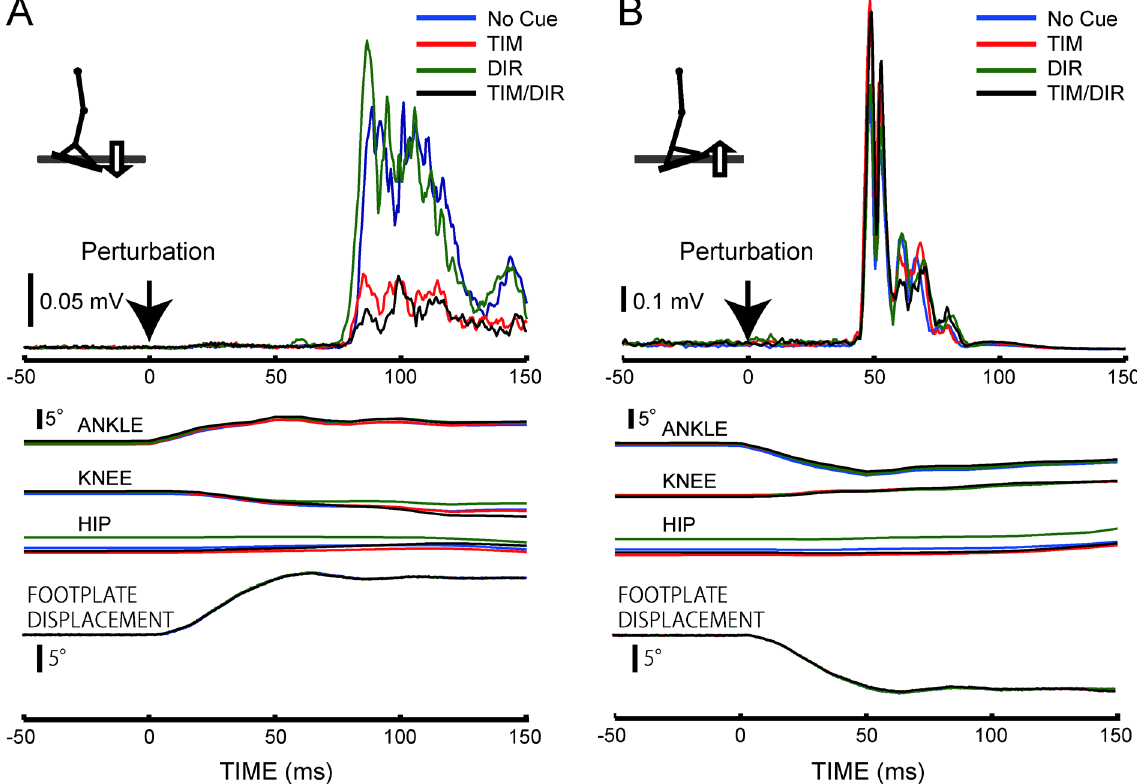
Fig 2. Representative ensemble-averaged waveforms of the stretch reflex responses with movement trajectories of the ankle, knee, and hip joints under the different cue conditions in a single subject. (A) In the TA muscles due to toes-down rotations. (B) In the SOL muscle due to toes-up